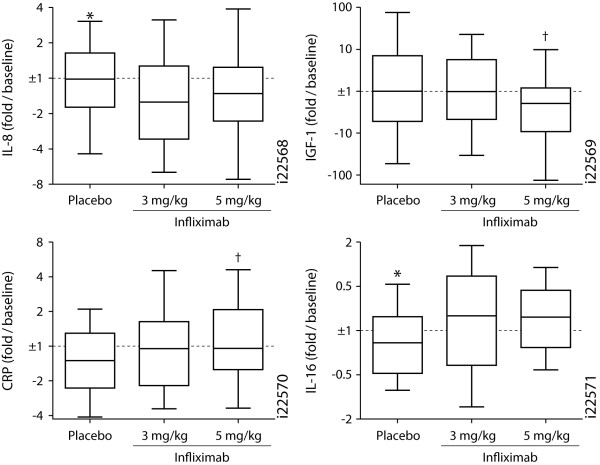
Changes in analyte concentrations after infliximab treatment. The serum concentrations of the indicated analytes at the 24-week timepoint for placebo and 3 and 5 mg/kg infliximab treatment groups in the T54 COPD cohort are shown as signed-fold over respective baseline concentrations. Data presented as box (median, interquartile range) and whiskers (10th-90th percentiles). *p < 0.05 for placebo vs 3 and 5 mg/kg infliximab groups combined; † p < 0.05 for 5 mg/kg infliximab group vs placebo. IL, interleukin; IGF-1, insulin-like growth factor-1; CRP, C-reactive protein.